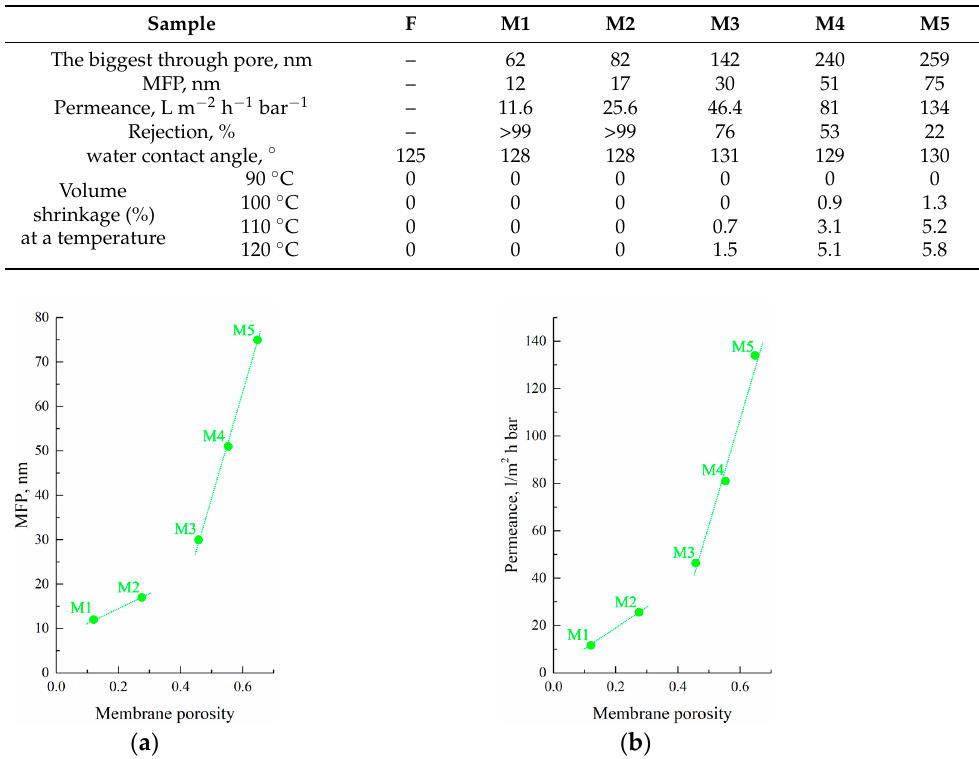
Figure 9. ( a ) MFP and ( b ) permeance as functions of the porosity of the obtained membrane samples. Table 4. The results of measurements of transport properties, water contact angle, and thermal stability of the initial fi lm and membranes.